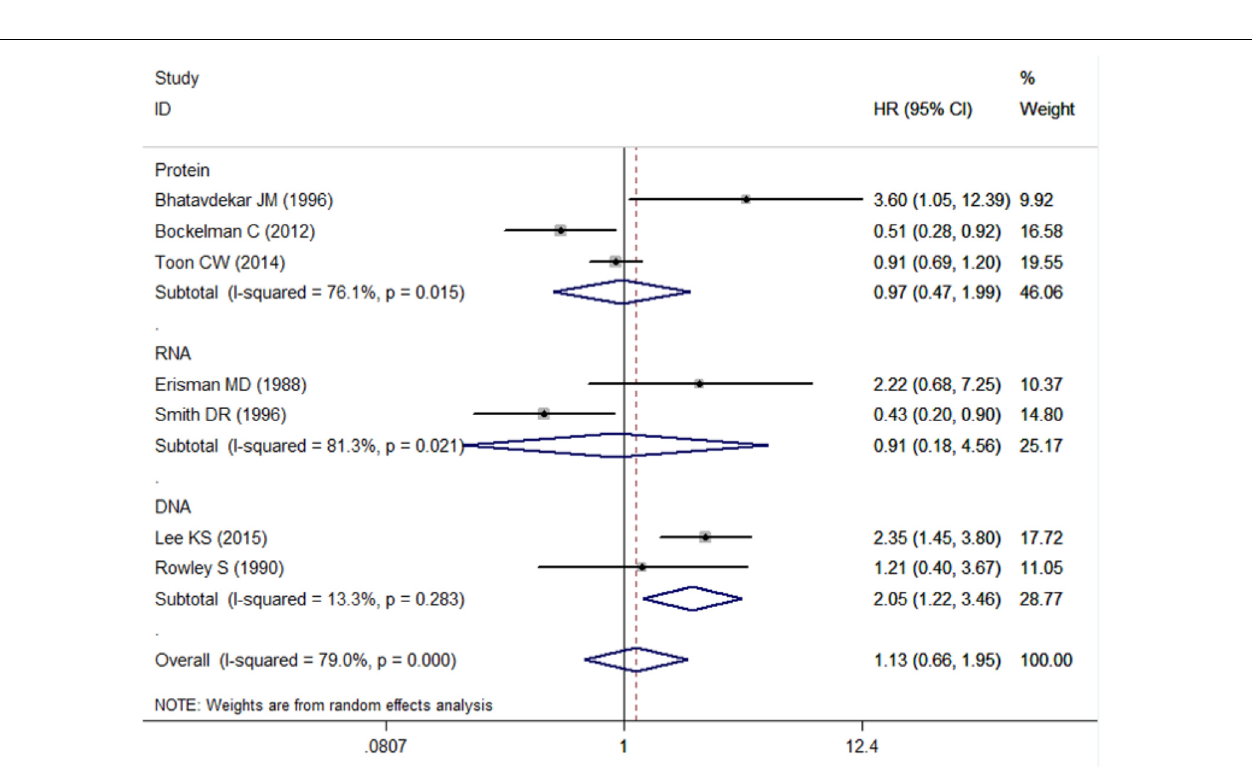
FIGURE 5 | Subgroup analysis for the association between c-Myc and overall survival in the studies using different test content (including Protein, DNA, RNA).